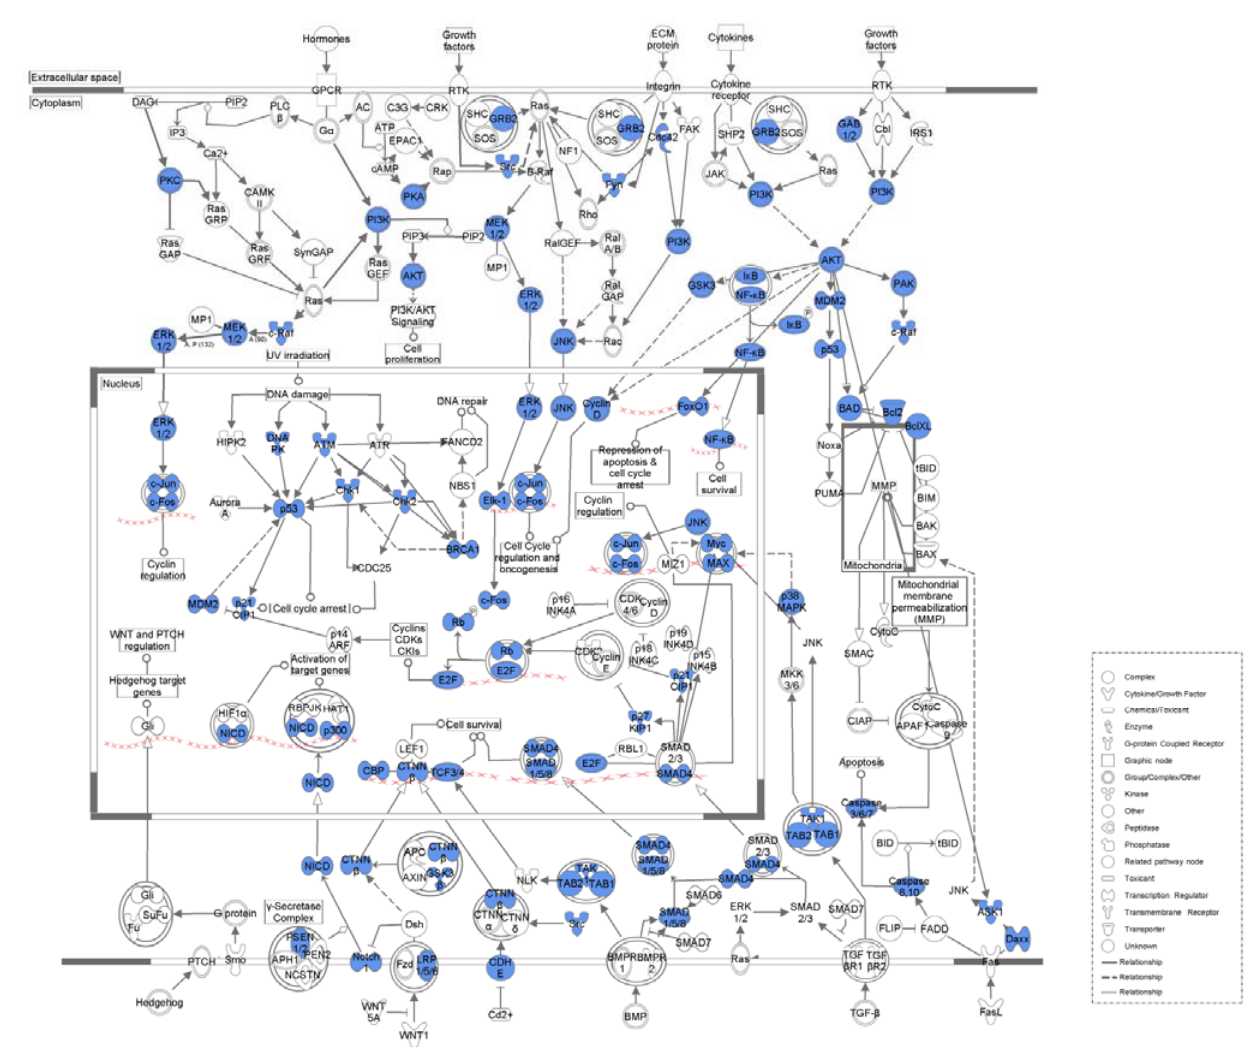
Figure 2. Molecular mechanisms of cancer associated with the common network. Blue legends represent proteins contained in the common